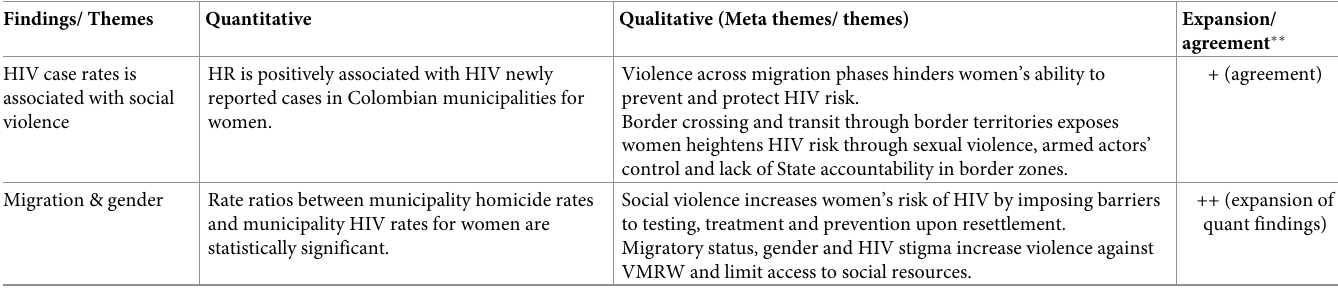
Table 5. Convergence/fit matrix of key quantitative and qualitative